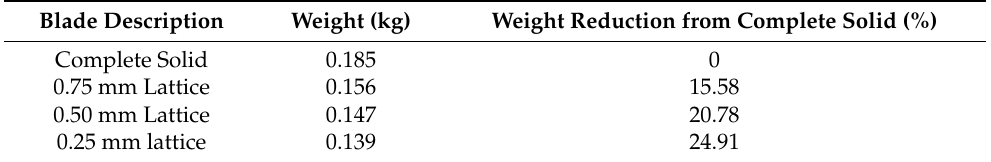
Table 2. Weight of turbine blades used in this